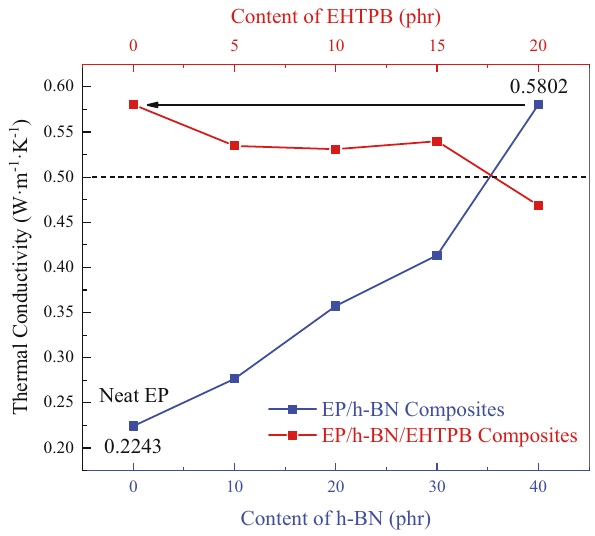
Figure 15: TC of prepared